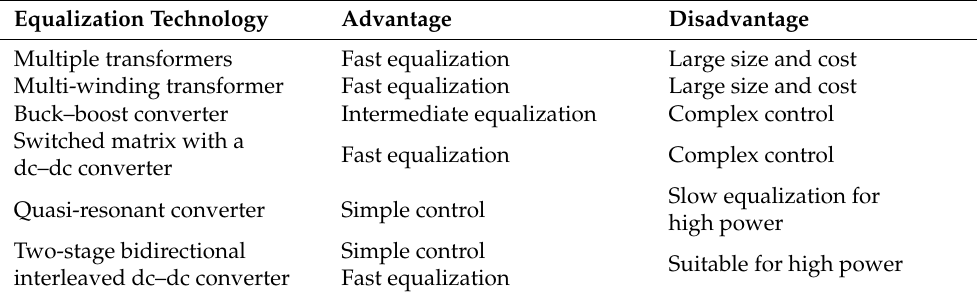
Table 1. Comparison between different active equalization systems [12].